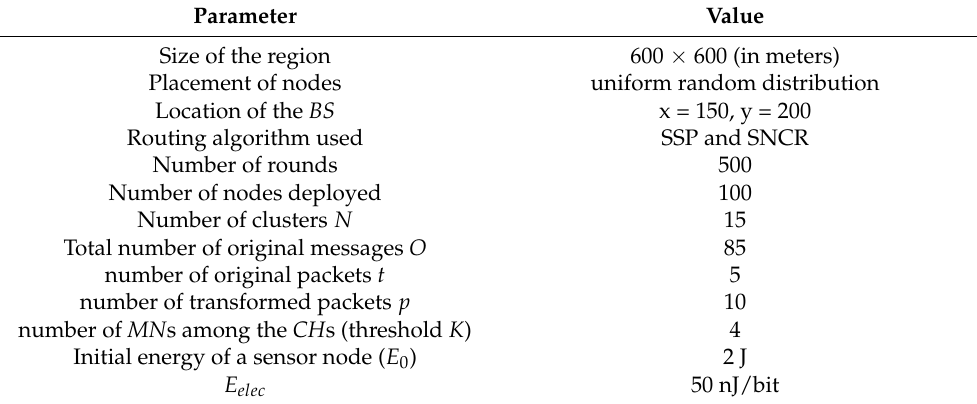
Table 1. Network parameters. Parameter